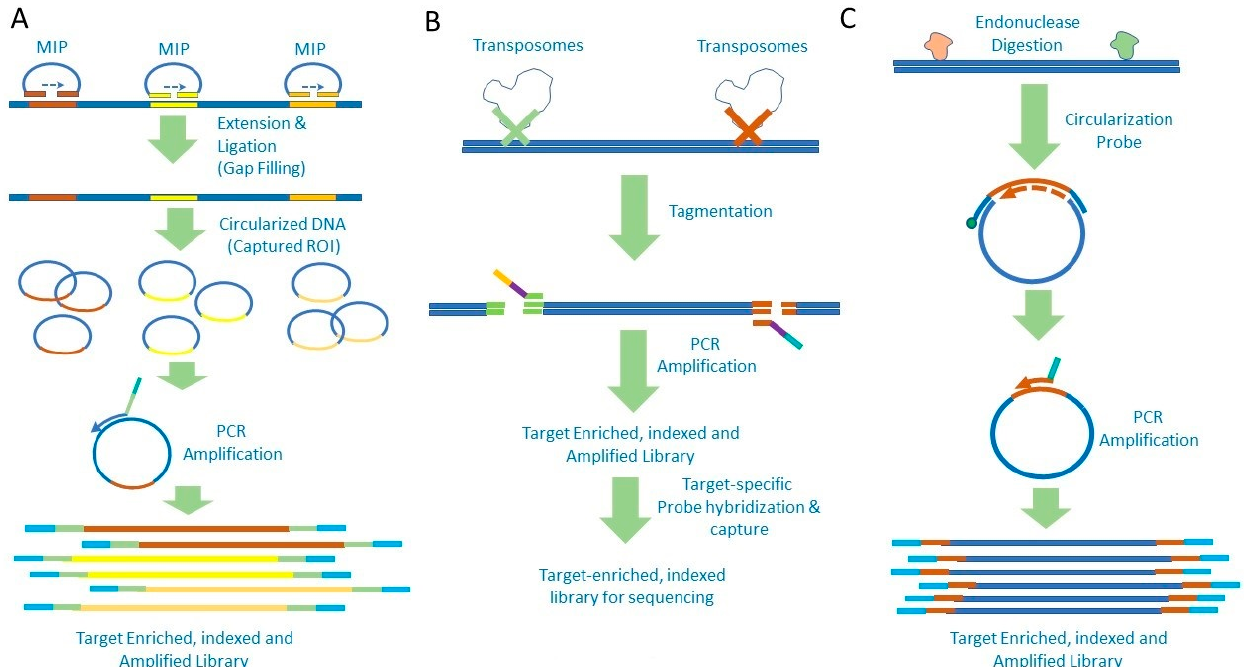
Figure 2. Variations of the Hybrid Capture Target Enrichment Methods. Some examples of variations of the hybrid capture methods are depicted. ( A ) Molecular inversion probe-based enrichment, where probes with sequences complementary to the target region of interest are used. Binding of the probes, followed by extension ligation results in circularized DNA with the target region included. Using these as templates, subsequently, a universal primer is used to linearize, amplify, and generate the sequencing library. ( B ) Tagmentation method, where transposomes are used to fragment double-stranded DNA and tag with sequencing adapters in a single step. This tagged genomic library is amplified using adapter-specific primers followed by hybrid capture with target-specific probes to isolate target-enriched library for sequencing. ( C ) Haloplex method, where biotin-labeled circularization probes are used to bind to endonuclease-digested DNA, followed by extension ligation, which results in circularized DNA with targeted region of interest, which is amplified using a universal primer to generate enriched library for sequencing.